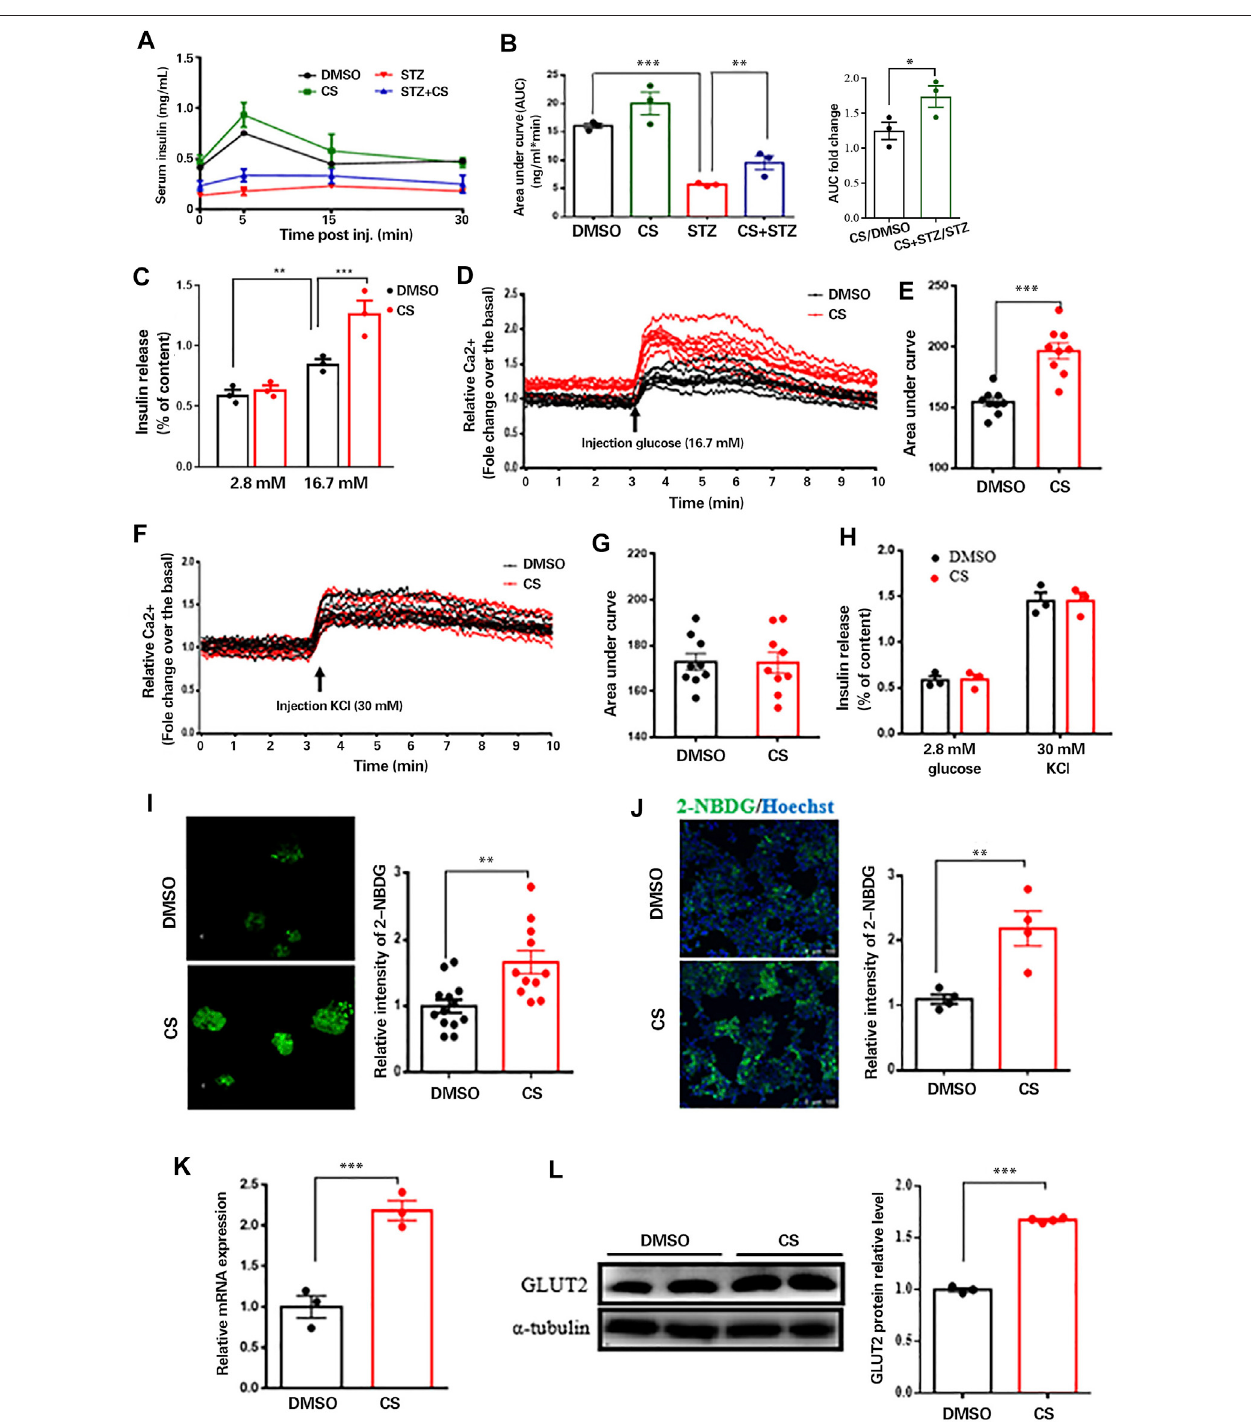
FIGURE5| CSrestoredinsulinsecretionfrom β -cellsresponsetoglucosenottodepolarizingsecretagogues. (A) Plasmainsulinconcentrationsweremeasuredat indicated time points during glucose-stimulated insulin secretion (GSIS) in response to administration of 3 g glucose/kg body weight in 12-h fasted mice ( n = 4 – 6 mice per group). (B) AUC calculated from GSIS data were compared. (C) Insulin secretion measured in isolated islets challenged with 2.8 or 16.7 mmol/L glucose. (D – G) Mouse islets were pretreated with or without CS (10 µM) for 12 h followed by a perfusion with KRB buffer-based solutions containing 16.7 mM glucose (D,E) or 30 mM KCl (F,G) , intracellular Ca 2+ were determined by ratiometric Fura-3AM fl uorescence measurements. Change of intercellular Ca 2+ contents (D,F) and the relative islet Ca 2+ in fl ux (AUC) during 10-min stimulation (E,G) . (H) Insulin release from isolated islets pretreated with or without CS (10 µM) for 12 h followed by a challenge of 30 mMKClin2.8 mMglucosebuffer. (I,J) Glucoseuptakeabilityinisolatedislets (I) orINS-1 β -cells (J) wasmeasuredusing2-NBDG.MouseisletsorINS-1 β -cellswere